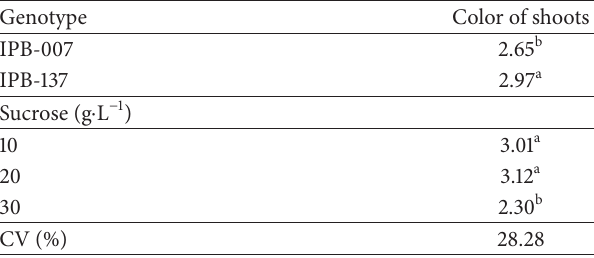
Table 8: Coloration of sweet potato plant shoots at 270 days of in vitro conservation under 18 ∘ C as a function of genotype and changes in MS salts and sucrose